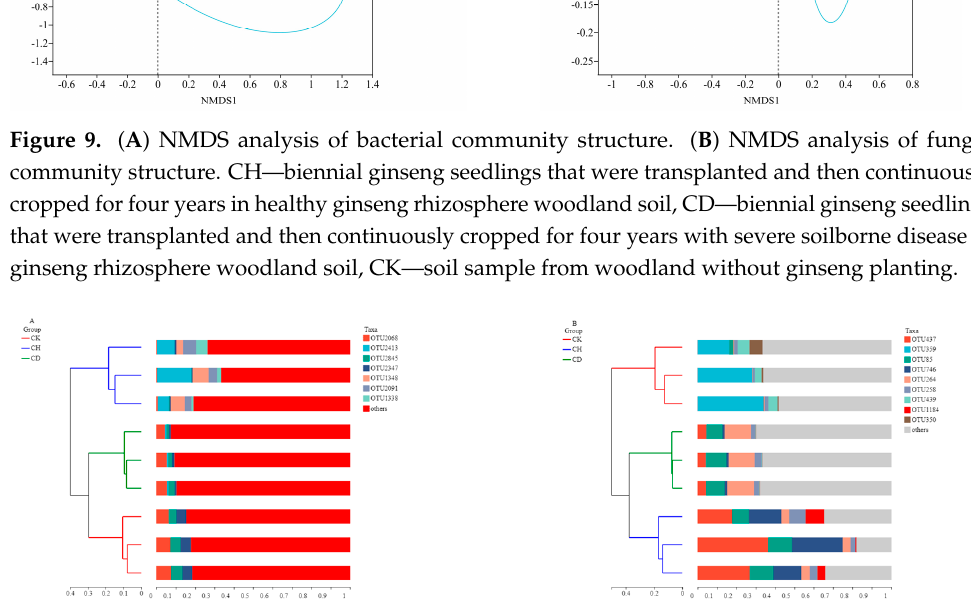
Figure 10. ( A ) UPGMA analysis of the bacterial community structure. ( B ) UPGMA analysis of the fungal community structure. OTUs representing less than 5% of the total composition were classified as ‘other’. CH—biennial ginseng seedlings that were transplanted and then continuously cropped for four years in healthy ginseng rhizosphere woodland soil, CD—biennial ginseng seedlings that were transplanted and then continuously cropped for four years with severe soilborne disease in ginseng rhizosphere woodland soil, CK—soil sample from woodland without ginseng